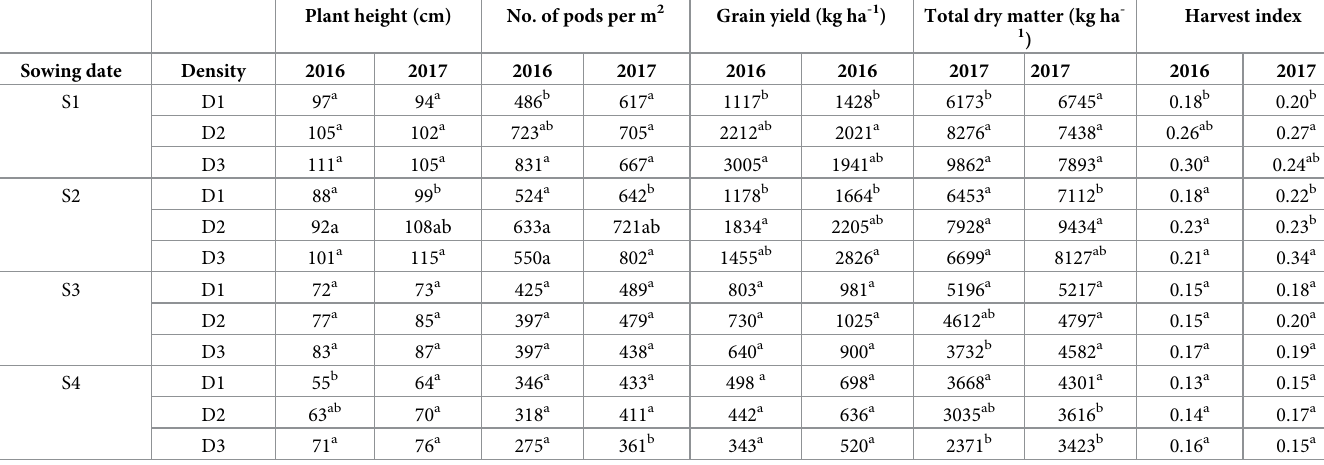
Table 6. Some agronomic traits affected by sowing date × plant density interaction